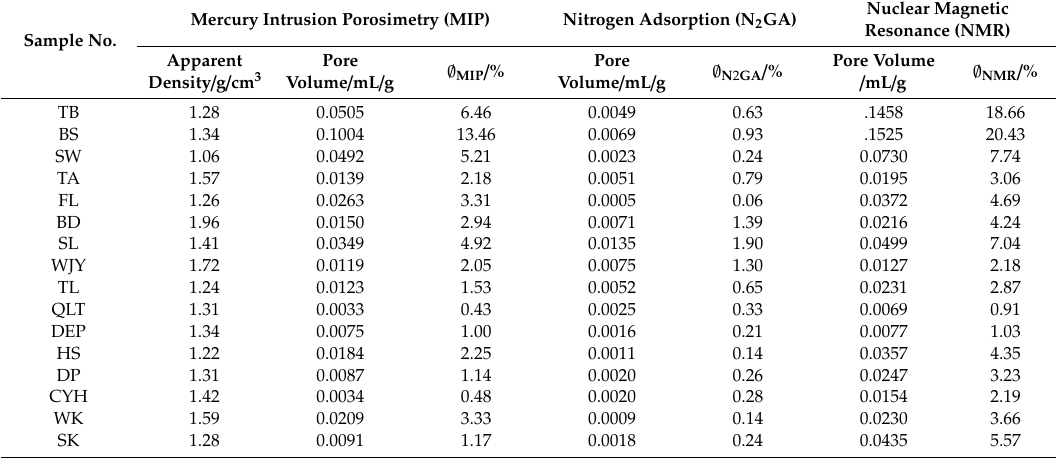
Table 5. Determination of di ff erent porosities and pore volume characterization of the porosity results.